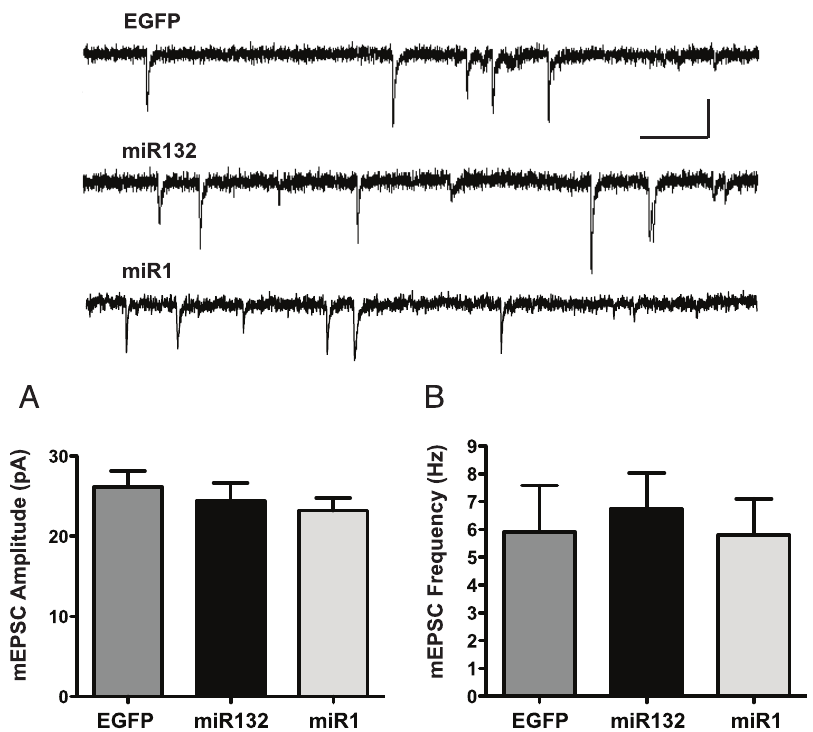
Figure 3. miR132 does not affect the size or the frequency of spontaneous mEPSCs. ( Top ) Traces show typical spontaneous mEPSCs recorded from control and miR132-overexpressing neurons (Scale bars, 20 pA, 100 ms). (A) There was no difference between groups in the average amplitude of mEPSCs. (B) There was no difference between groups in the average frequency of mEPSCs. (for all groups, n =15).